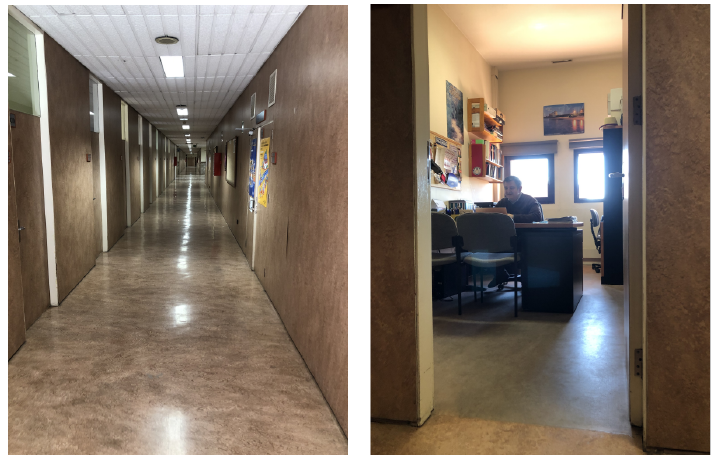
Figure 7. Examples of scenes on the real scenario where the mobile robot was deployed to capture 2D and 3D data: corridor ( left ) and office ( right